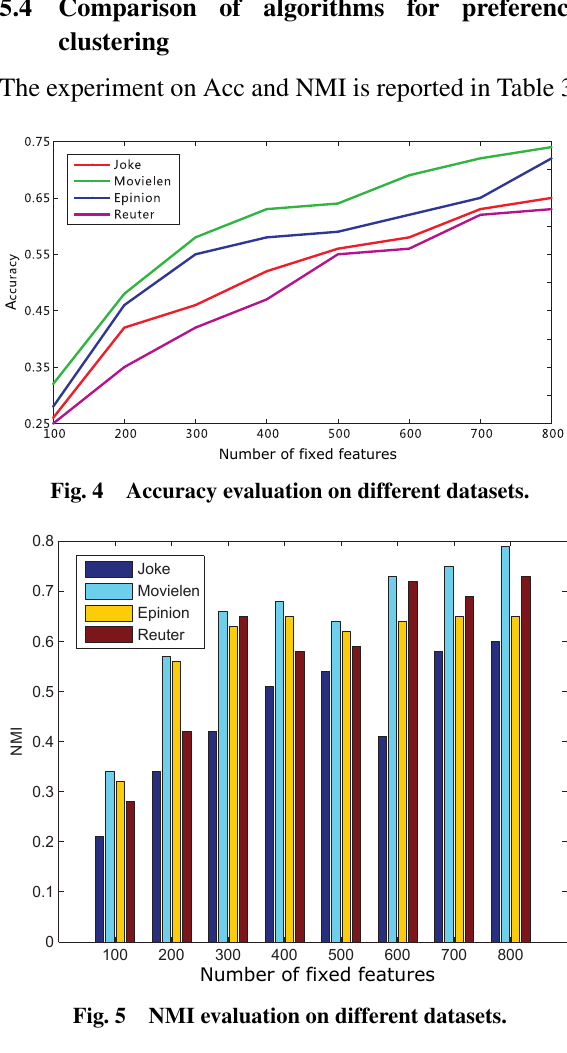
Fig. 6 NMI of different clustering methods by fixed sampling.